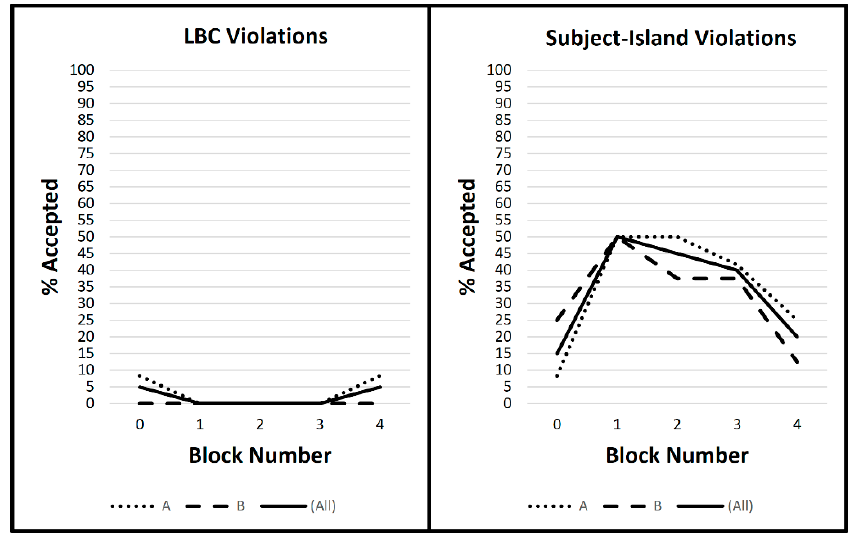
Figure 3. Experiment I, LBC and Subject-Island violations.